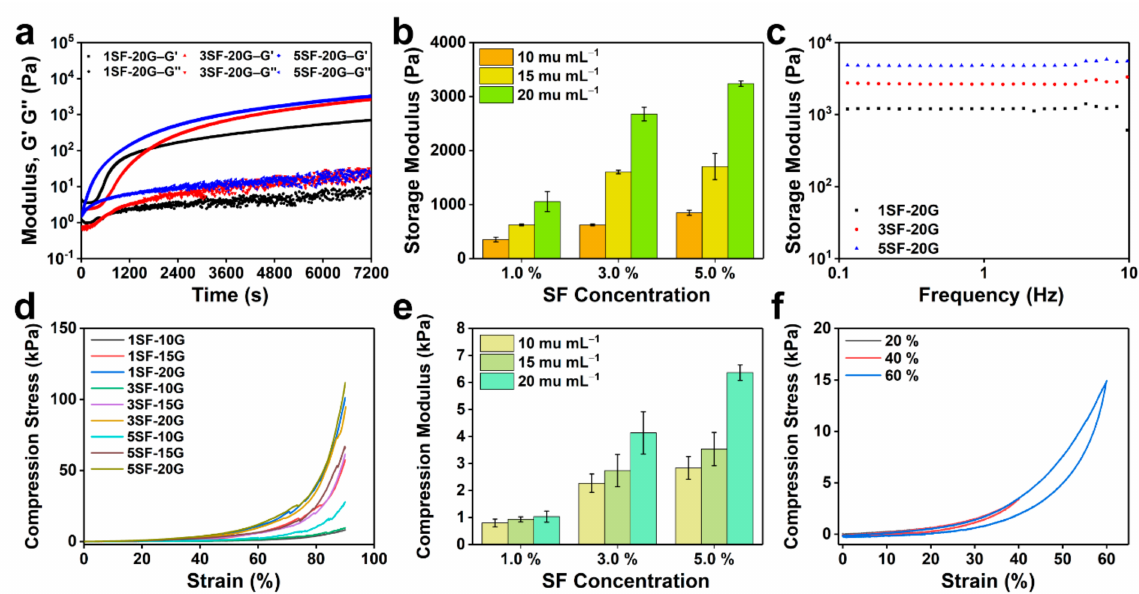
Figure 3. Rheological and mechanical properties of SF hydrogels. ( a ) The storage modulus (G (cid:48) ) and loss modulus (G (cid:48)(cid:48) ) of SF/glucose/GOx/Hb (GOx: 20 mu mL − 1 ) hydrogels with different SF content under time sweep. ( b ) G (cid:48) of SF hydrogels with varying SF and GOx concentrations. ( c ) G (cid:48) of SF/glucose/GOx (20 mu mL − 1 ) with different SF concentrations under frequency sweep. ( d ) The compression stress–strain curves of SF hydrogels. ( e ) The compression modulus of SF hydrogels with varying SF and GOx concentrations. ( f ) The cyclic compression stress–strain curves of the 5SF-20G hydrogels. Error bars represent the mean ± s.d.; n ≥